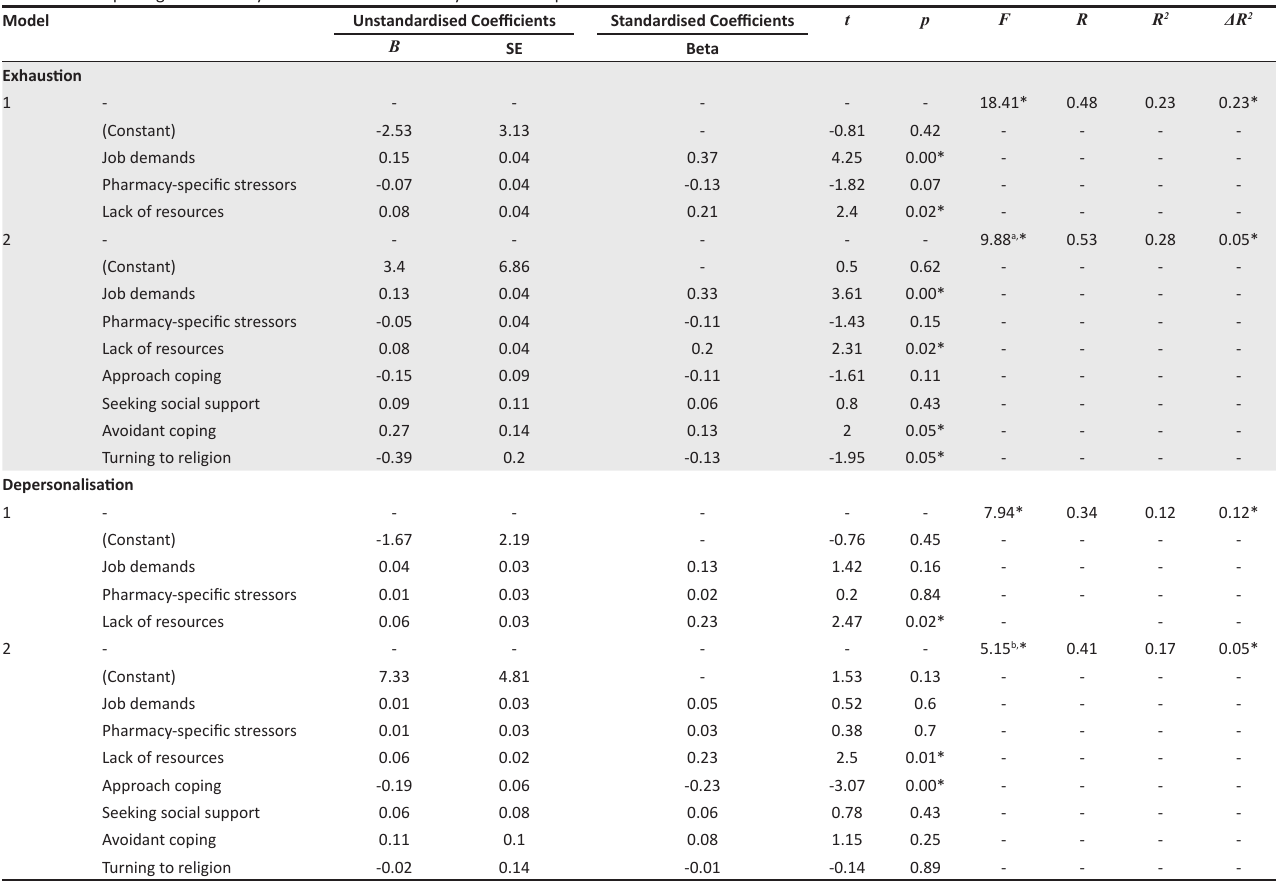
TABLE 4: Multiple regression analysis with exhaustion and cynicism as dependent variables.